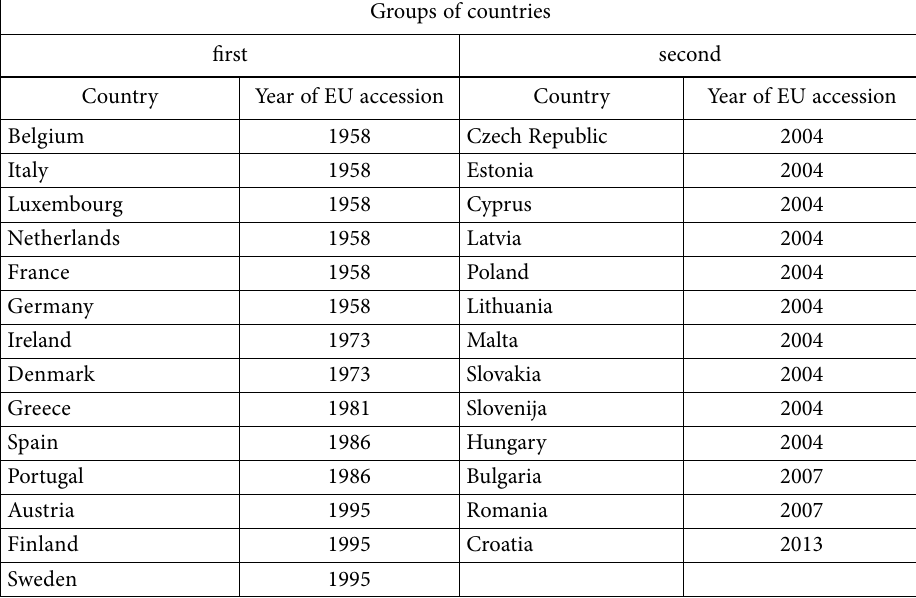
Table 2. Countries of the European Union: year of accession (source: compiled by the authors) Groups of countries first second